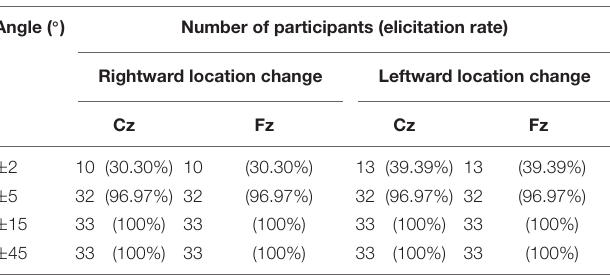
TABLE 5 | The number and proportion of participants with a clear waveform in each condition.